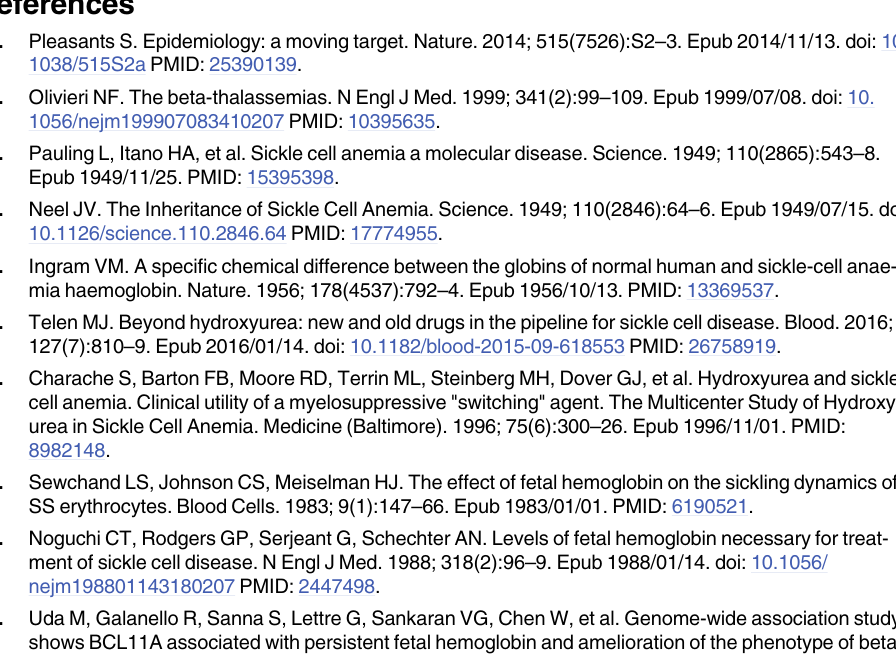
S3 Fig. Effects of HMGA2 over-expression on the levels of (A) alpha -, (B) beta -, and (C) gamma-globin transcripts according to individual donors. Quantitation of copy number per nanogram cDNA (copies/ng cDNA) was performed by Q-RT-PCR at culture day 14. Standard deviation was calculated for each sample in triplicate reactions. (D) Effects of HMGA2 over- expression on the levels of fetal hemoglobin (values for each donor are shown). Fetal hemoglo- bin levels were measured by HPLC analysis of hemoglobin collected at culture day 21 from HMGA2-OE and empty vector control transductions. Open bars represent empty vector con- trol and black bars represent the HMGA2 over-expression. C = empty vector control transduc- tion; OE = HMGA2